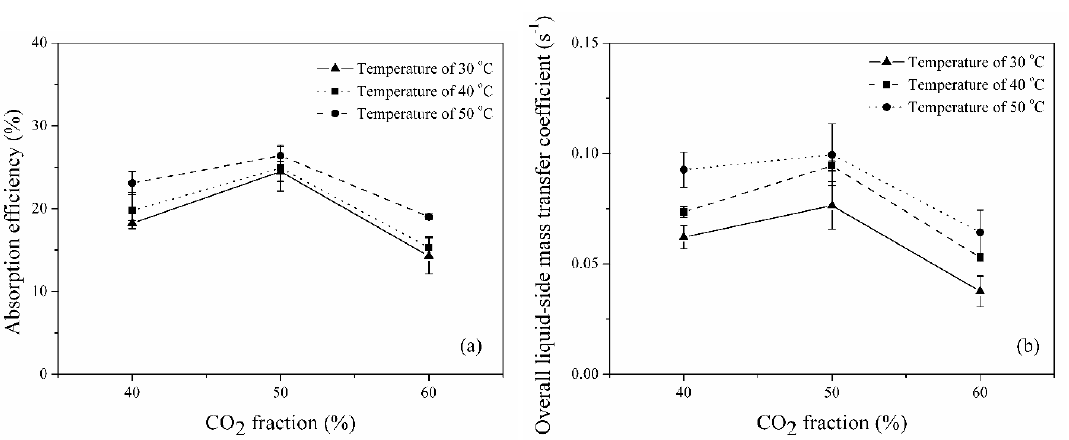
Figure 4. Effects of CO 2 fraction and absorption temperature on the responses: ( a ) absorption efficiency, ( b ) overall liquid-side mass transfer coefficient.